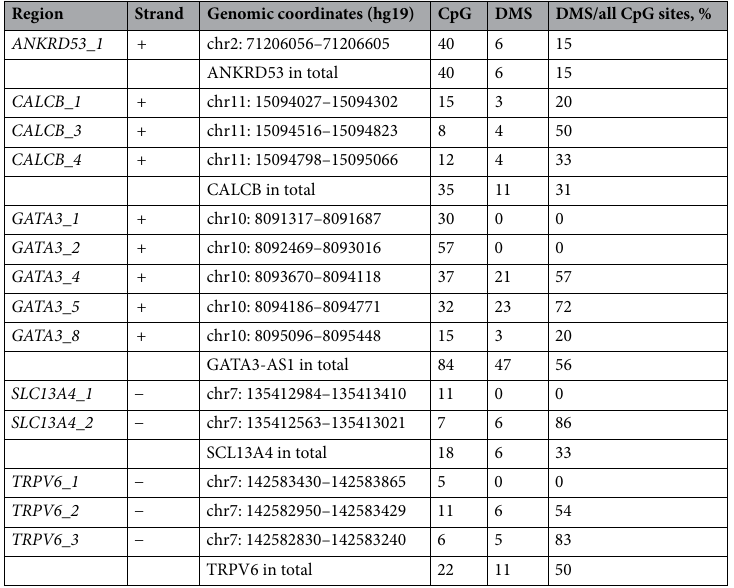
Table 2. Localization and methylation of CpG sites of 5 differentially methylated genes analyzed by targeted bisulfite massive parallel sequencing in chorionic villi of miscarriages with trisomy 16.